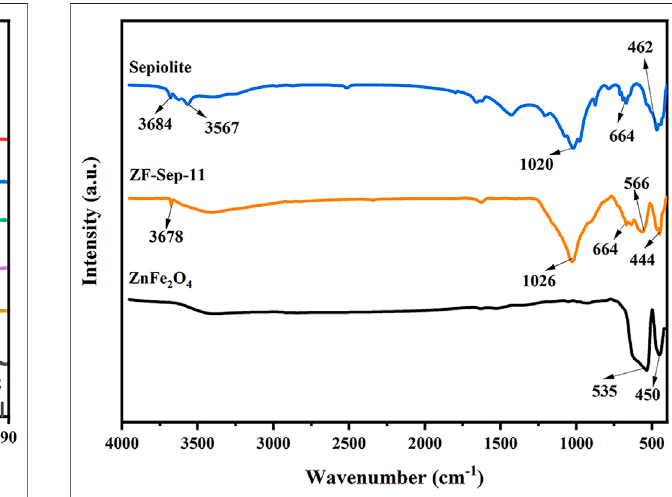
FIGURE 2 | XRD patterns of ZnFe 2 O 4 and ZF-Sep composites with different ZnFe 2 O 4 loadings.